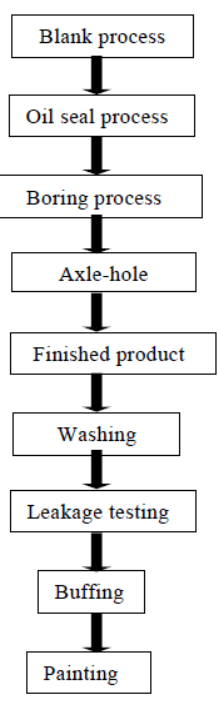
Figure 3. Sequences of bottom case making processes